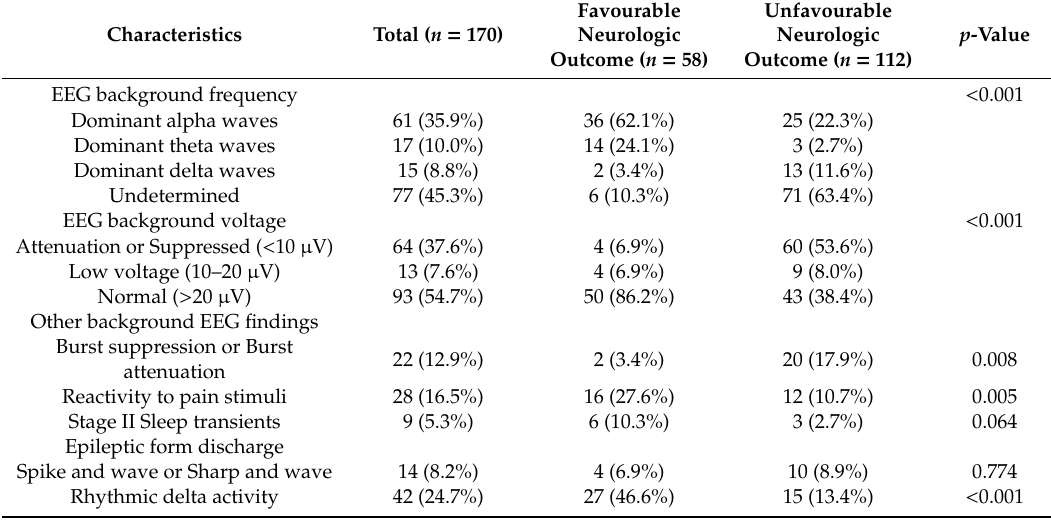
Abbreviations: EEG,